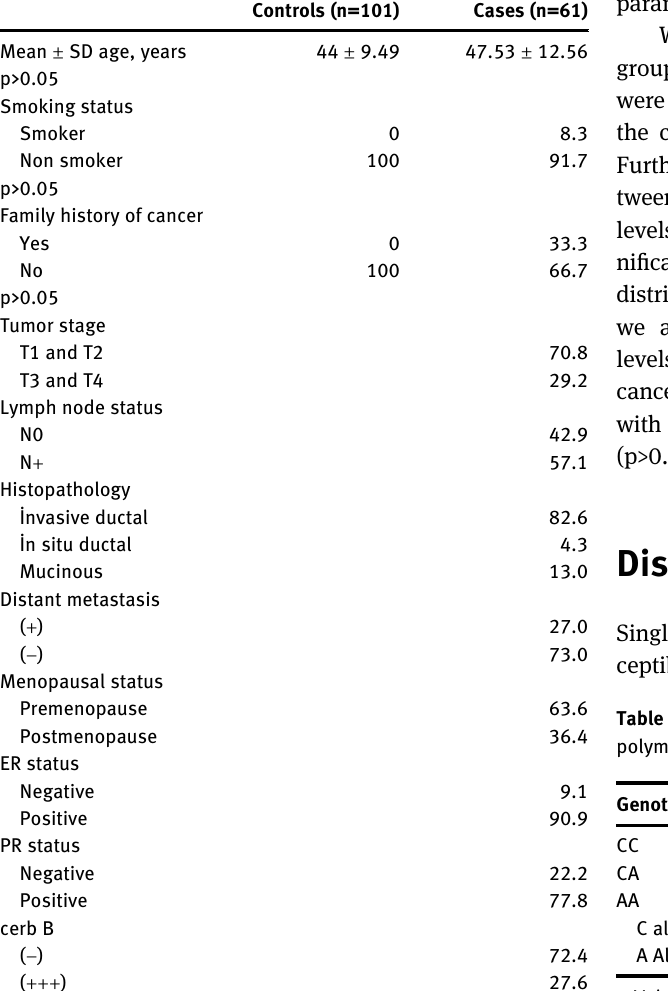
Table  : Clinical features of control individuals and BC cases (%).